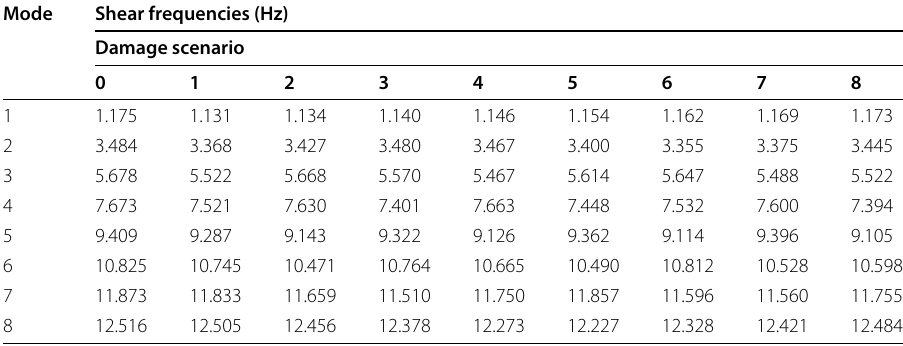
Table 1 Shear vibration frequencies of the considered eight-story building, for the undamaged case ( 0 ) and under different damage scenarios, each one featuring a reduction by 25% of the stiffness at the inter-story corresponding to the scenario label Mode Shear frequencies (Hz) Damage scenario 0 1 2